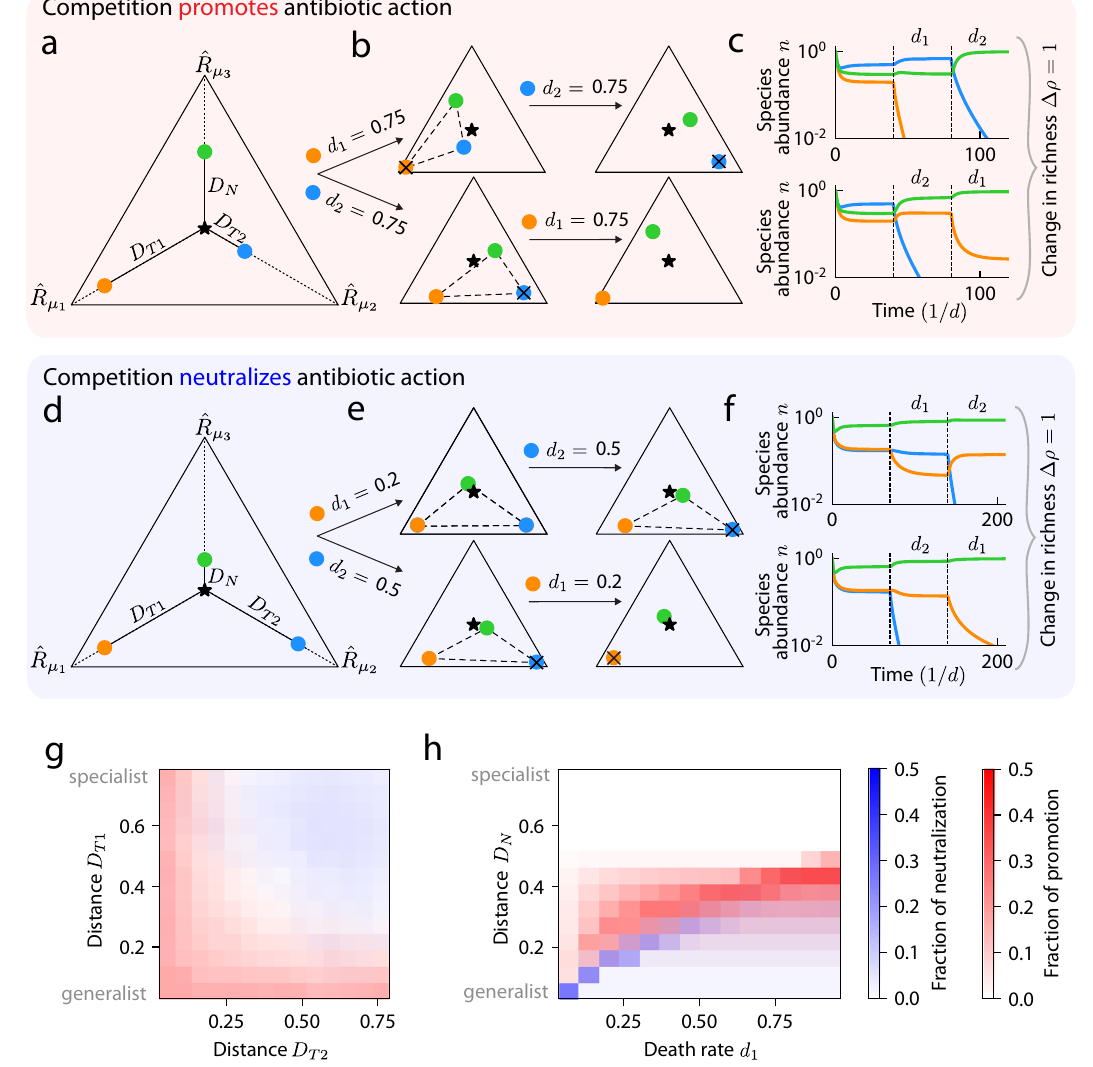
Fig.4|Finalcoexistenceisdependentonthesequenceofantibiotictreatment. a An example community of three species (colored circles) for which the sequence of narrow-spectrum antibiotics can affect the fi nal richness. The blue species promotes the action of the antibiotic that targets the orange species, causing the fi nal richness to be non-transitive to the sequence of antibiotic treatment. b (Top left) Remapping of the consumption niche of all species when the death rate of the orange species was increased. The orange species went extinct, as the remapped convex hull does not enclose the supplied resource point.(Topright)Increasingthedeathrateofthebluespeciesaftertheextinction oftheorangespeciesledtoitsextinction.(Bottomrow)Sameastoprow,butthe sequence of sequential antibiotics was reversed. Now, the green and orange species coexisted after the two treatments, thus 4 ρ =1. c Population dynamics were simulated until steady state for the scenarios in ( b ): (top) fi rst with zero death rates, then with nonzero death rate for the orange species, then with